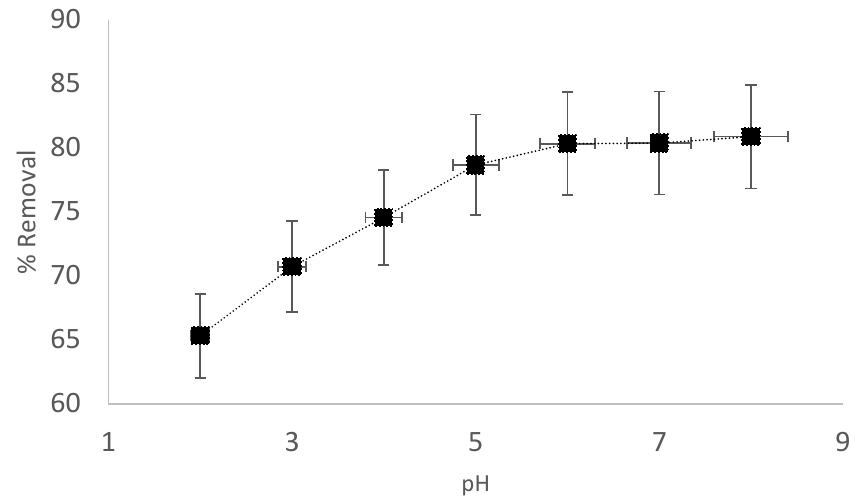
Figure 4 . Effect of pH on biosorption process.